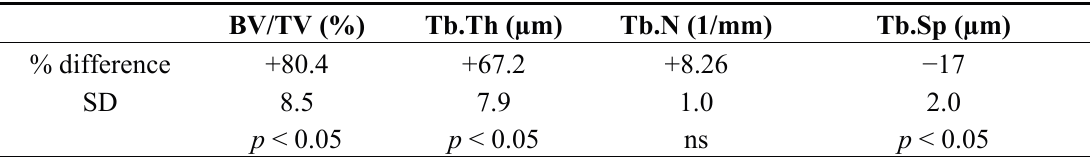
Table 2. Densitometric indices for the vertebral bodies (mean % difference ± SD) between WT and Col11a1 − / − BV/TV (%) Tb.Th (µm) Tb.N (1/mm) Tb.Sp (µm) % difference +80.4 +67.2 +8.26 − 17 SD 8.5 7.9 1.0 2.0 p < 0.05 p < 0.05 ns p < 0.05 BV/TV, Tb.Th, Tb.N and Tb.Sp are reported as percent difference between Col11a1-deficient